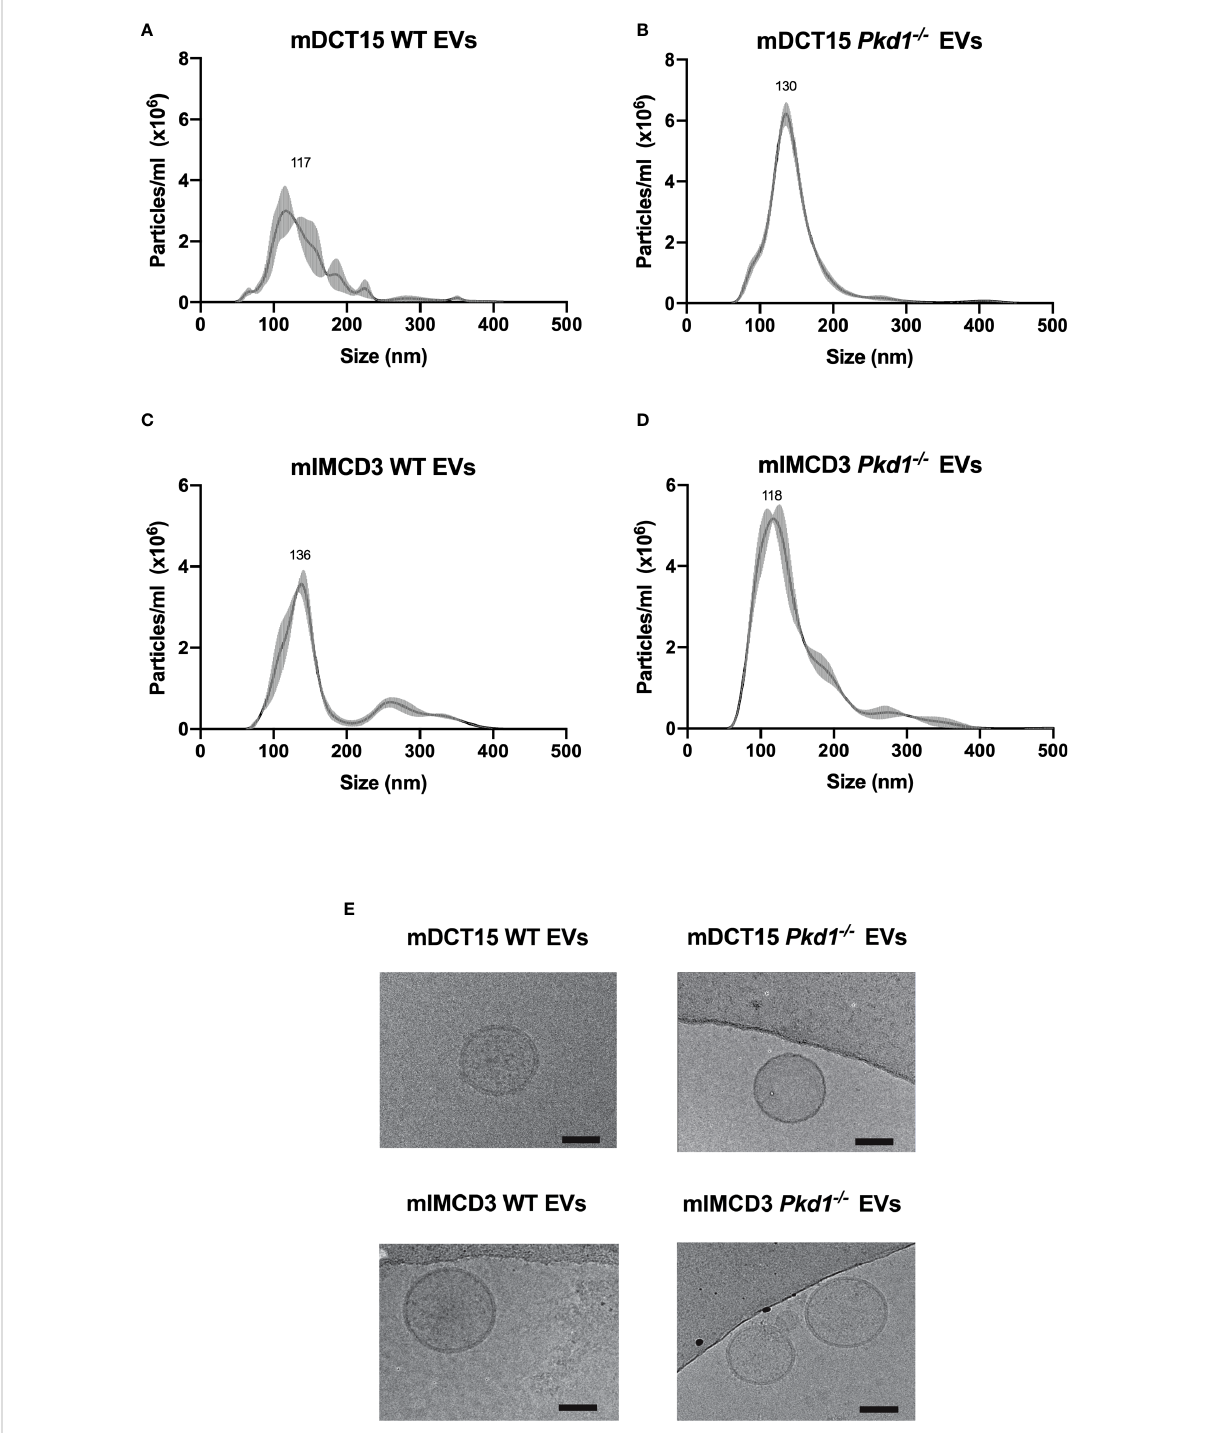
FIGURE 1 Characterization of EVs obtained from culture medium of mDCT15 and mIMCD3 cells. EVs from culture medium of mDCT15 wild type (A) and Pkd1 -/- (B) cells and from mIMCD3 wild type (C) and Pkd1 -/- (D) cells were characterized by NTA and transmission electron microscopy (E) . Scale bar: 50